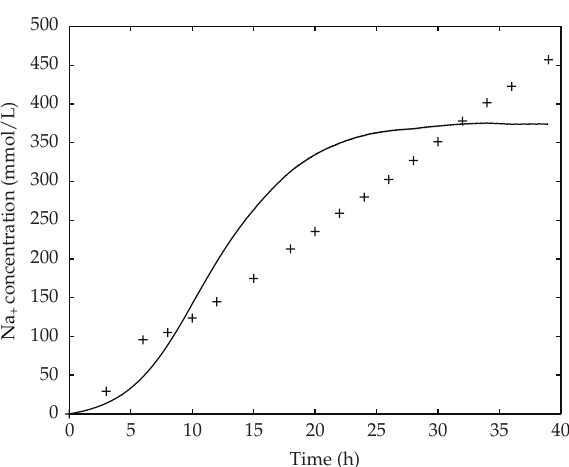
Figure 7: Comparison of Na (cid:9) ions concentration between experimental data and computational